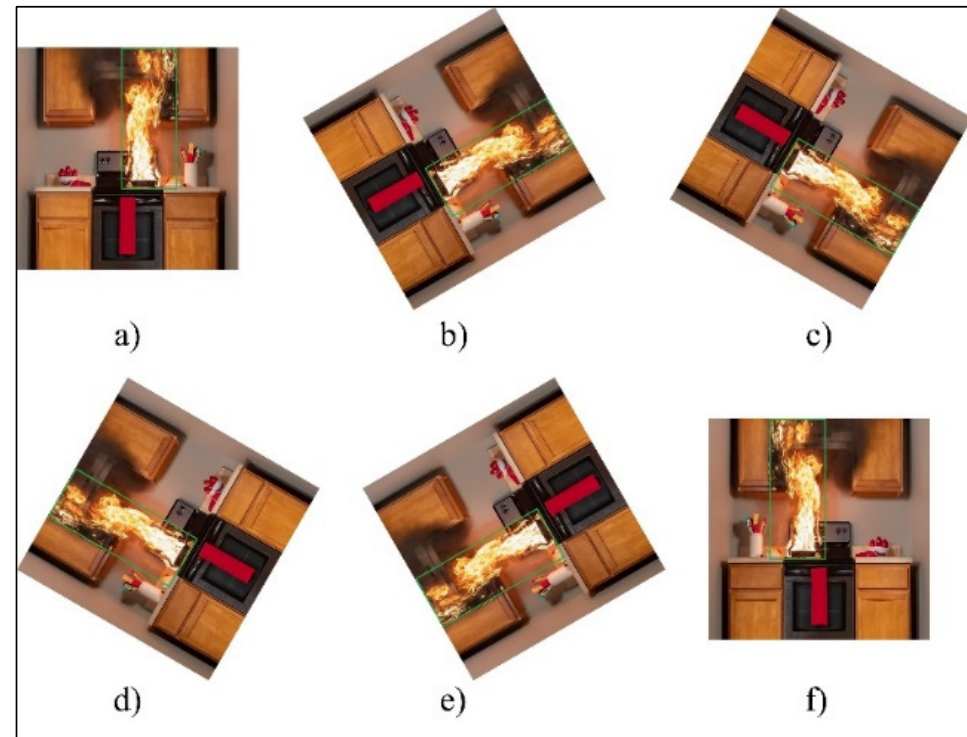
Figure 3. Image data augmentation using geometric transformations: ( a ) original image; ( b ) 60° rotation; ( c ) 120° rotation; ( d ) horizontal flipping of 60° rotated image; ( e ) horizontal flipping of 120° rotated image; ( f ) horizontal flipping of original image.